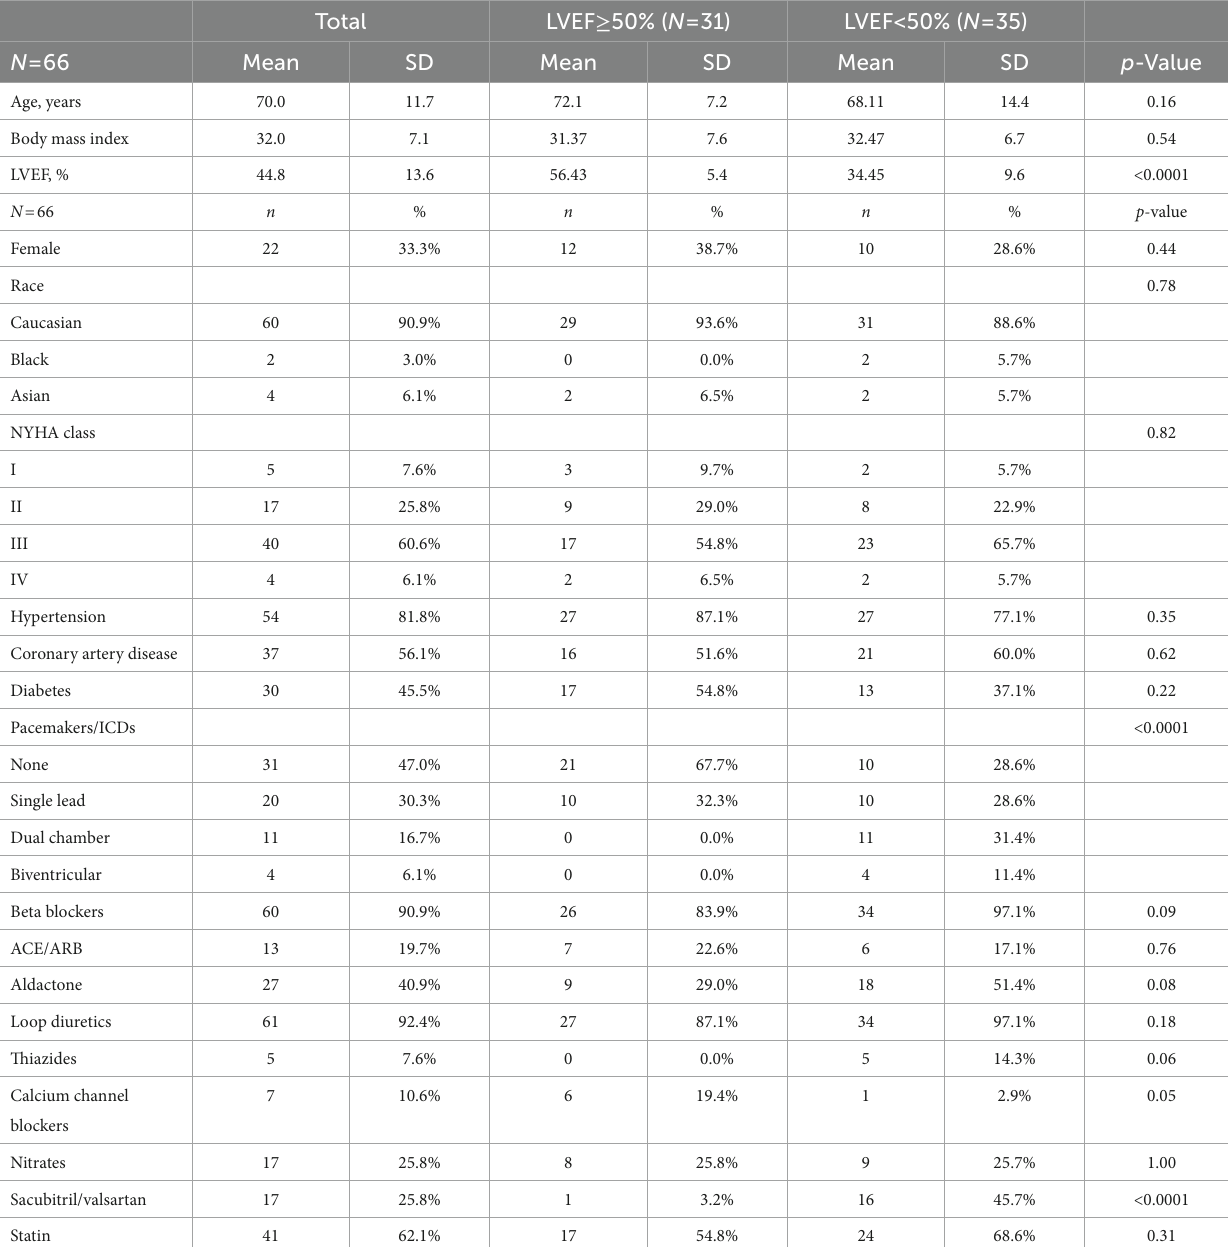
TABLE 1 Baseline Characteristics of patient